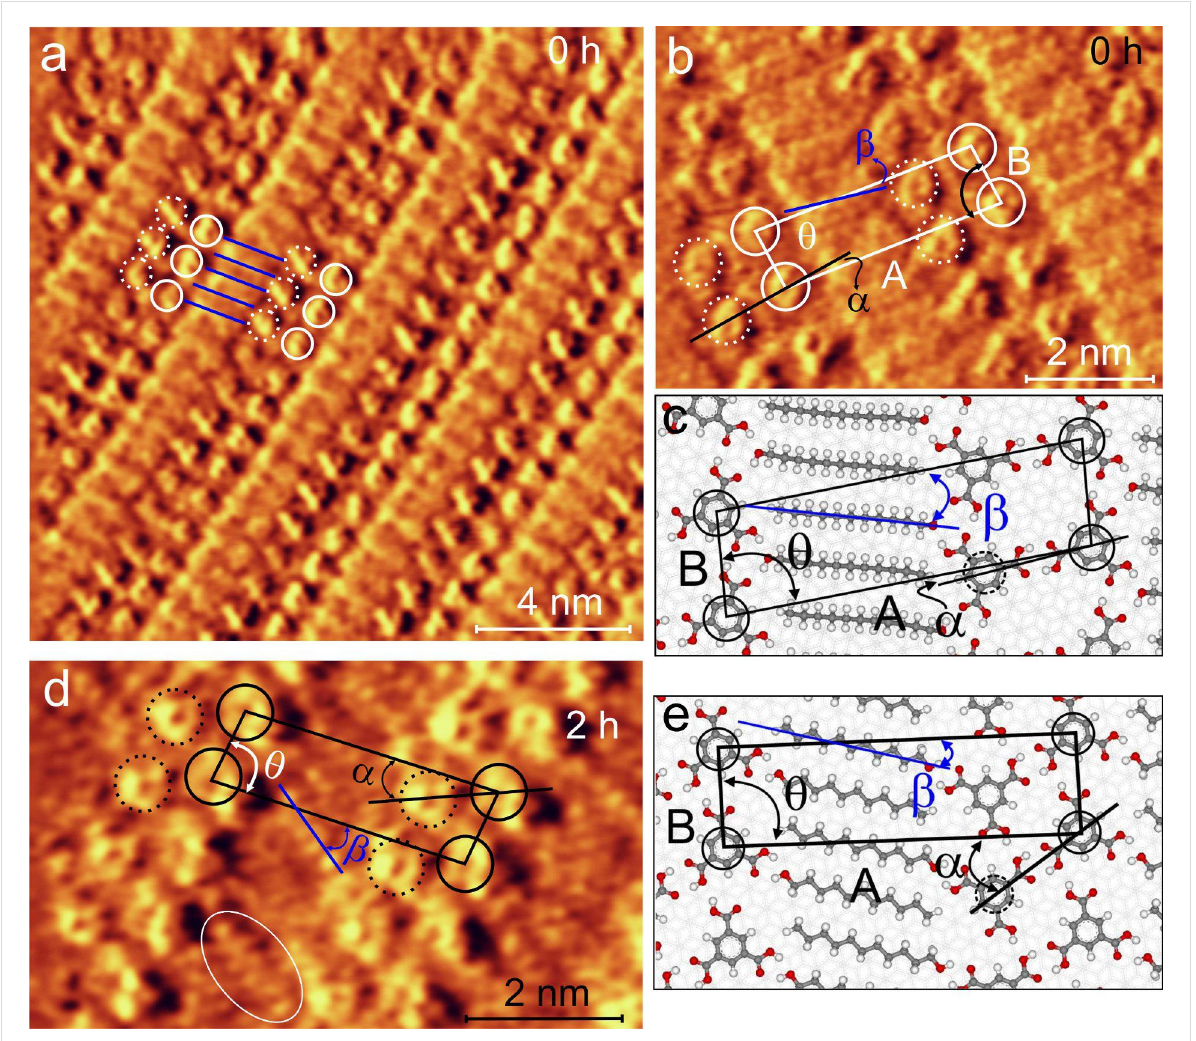
Figure 2: a) STM constant height image (1.2 V, 1 nA) of a TMA–undecanol linear pattern (LP0) formed on HOPG (0001) from solution without previous sonication. The LP0 consists of alternating TMA dimer tapes (dashed and full-line circle pairs) between lamellas of undecan-1-ol (blue lines); (a) is reproduced from [25], copyright 2013 Elsevier. b) A magnified section of LP0: the unit cell (parallelogram) contains two TMA and two undecanol molecules; A and B are unit cell parameters and θ is the angle embedded between them. β is the angle between the molecular axis of the undecanol back bone and the long axis of the unit cell. α describes the relative orientation of the TMA dimer with respect to the long axis of unit cell. c) Dreiding force field optimized geometric model (initial geometry based on experiments) of the LP0. d) STM constant height image (1.2 V, 1 nA) of TMA–unde- canol LP2 structure formed on HOPG (0001) from solution sonicated for 2 h and the corresponding Dreiding force field optimized geometry (e). The white oval in (d) shows a submolecularly resolved undecyl chain part of undecanol.